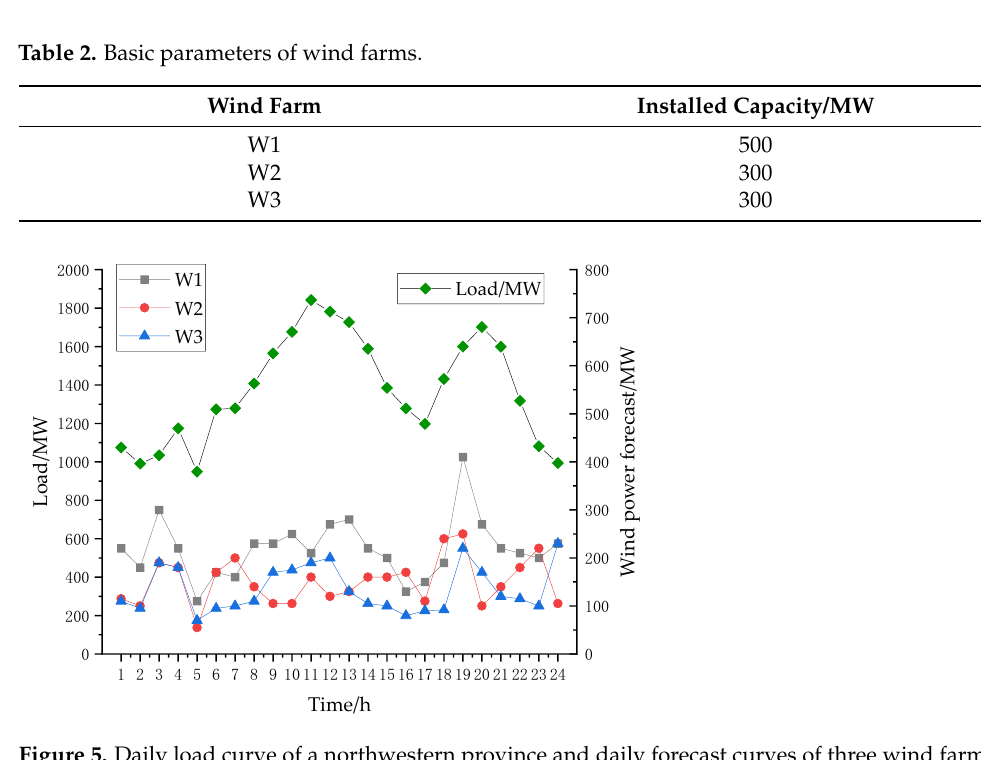
Table 2. Basic parameters of wind farms.